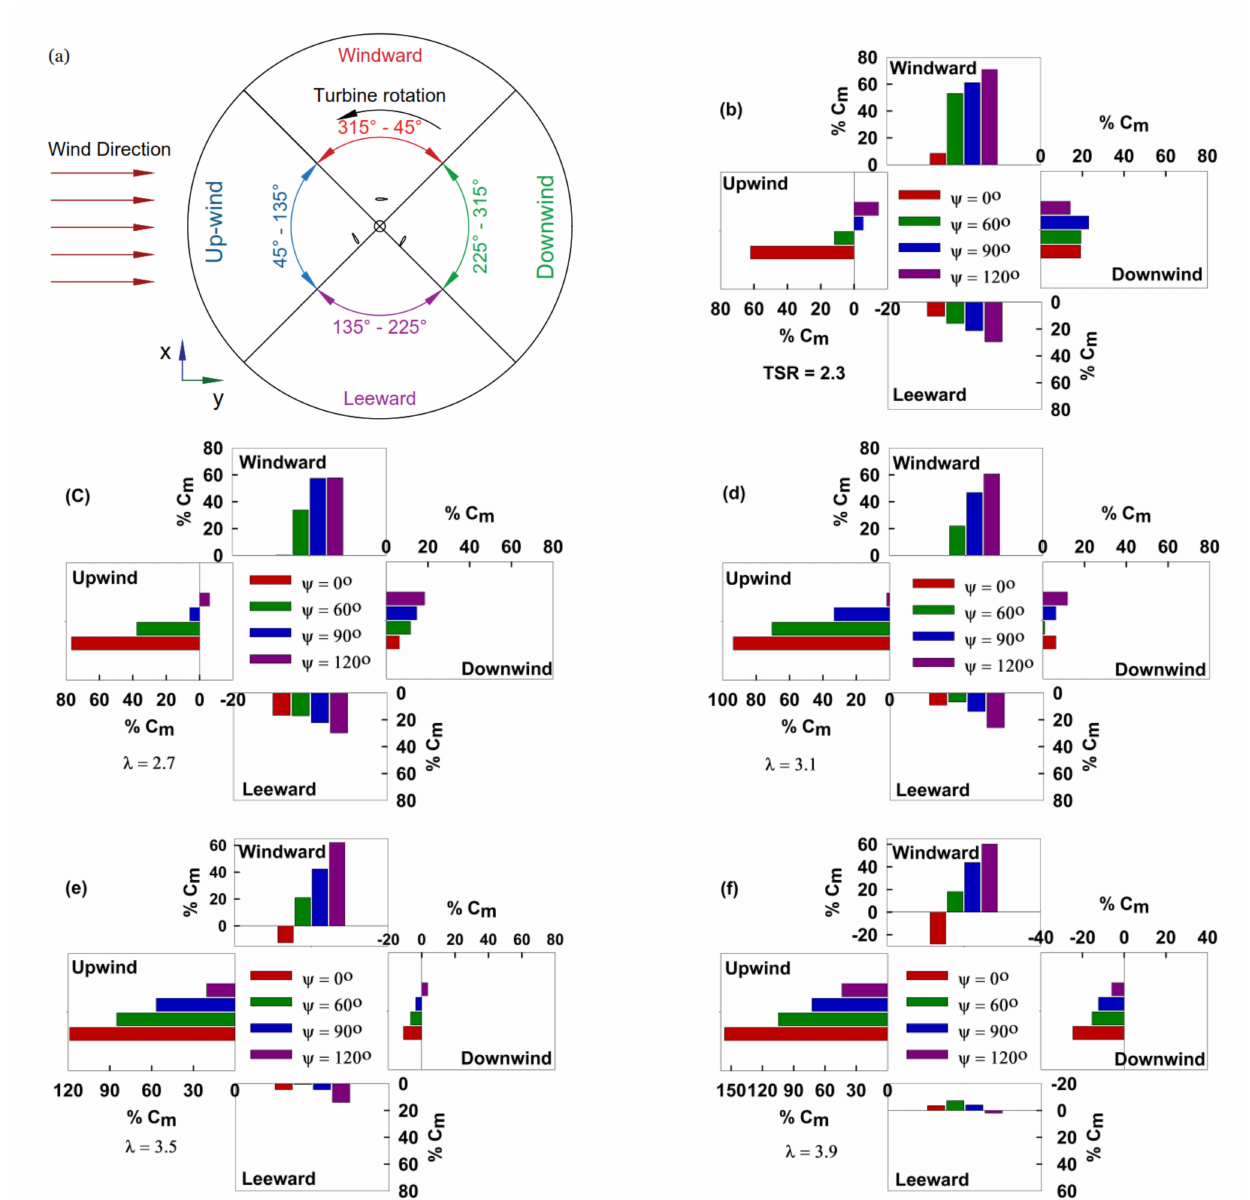
Figure 13. ( a ) Definition of quartile and percentage contribution by a blade in each quartile for all helical blades and straight blades at ( b ) TSR = 2.3, ( c ) TSR = 2.7, ( d ) TSR = 3.1, ( e ) TSR = 3.5, and ( f ) TSR =